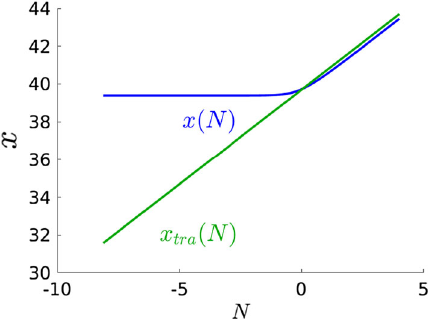
Fig. 7 Comparison of the dynamics of the tracker solution ( x tra ( N ) ; green curve) and our solution ( x ( N ) ; blue curve) for the exponential potential with γ = 1 and reheating temperature T rh = 100 TeV